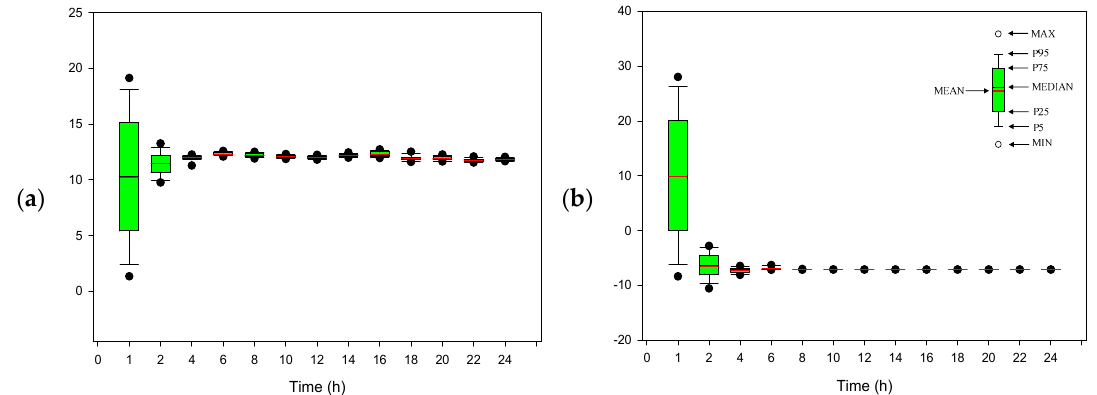
Figure 5. Variations of parameters ( a ) and ( b ) in Model (20) during the data assimilation process under scenario A 1.